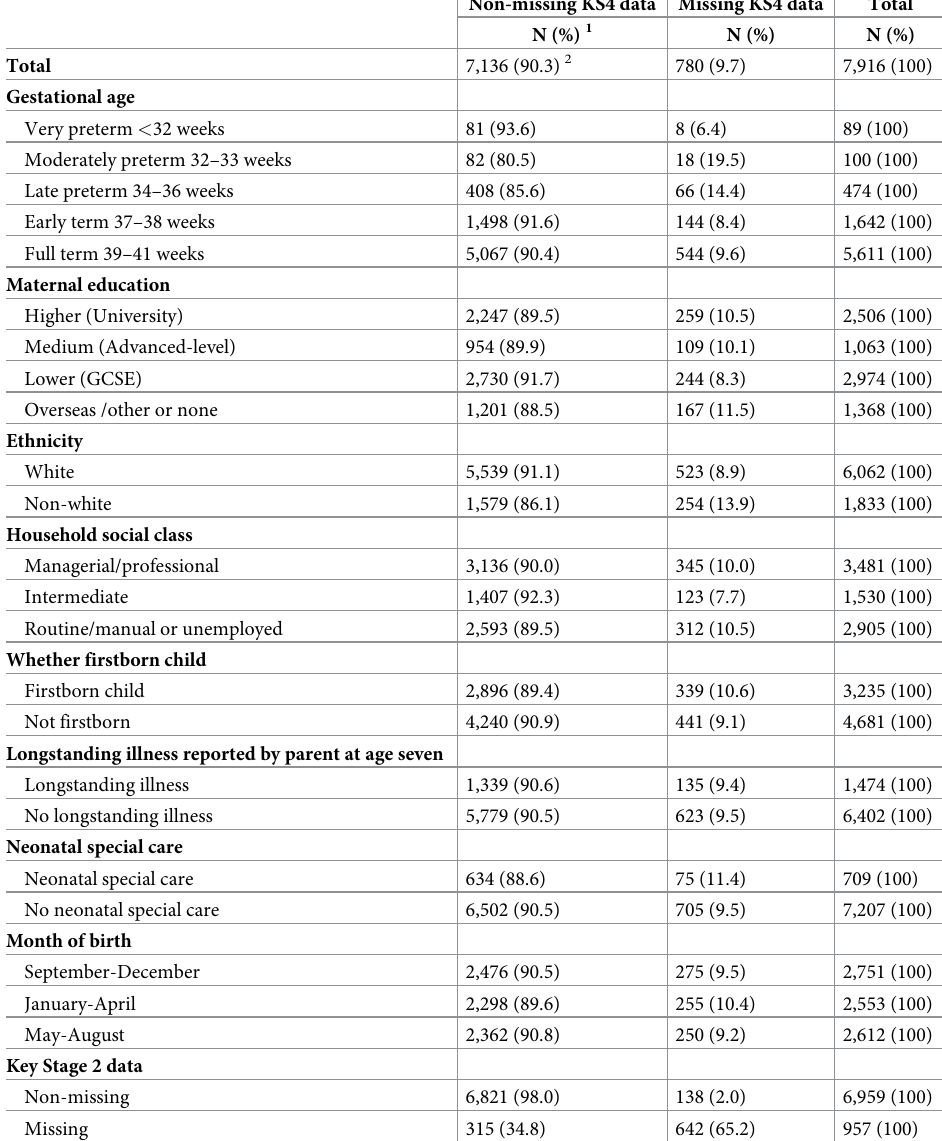
Table 3. Proportion of missing Key Stage 4 (KS4; secondary school; age 16) data within the Millennium Cohort Study